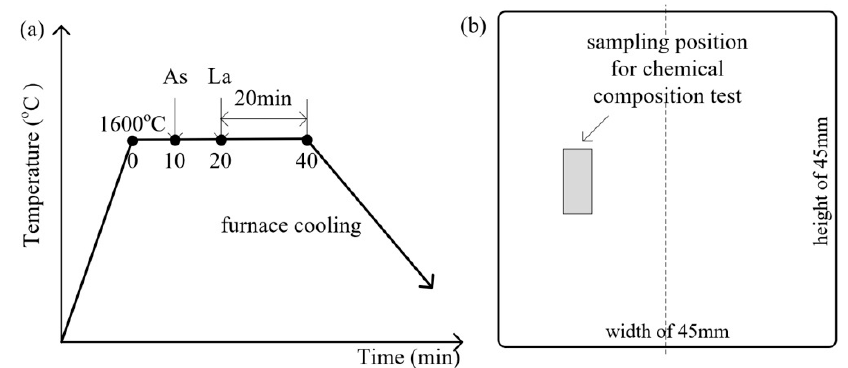
Figure 1. The process of sample preparation: ( a ) the steelmaking process; ( b ) the sampling position on the profile of the ingots.